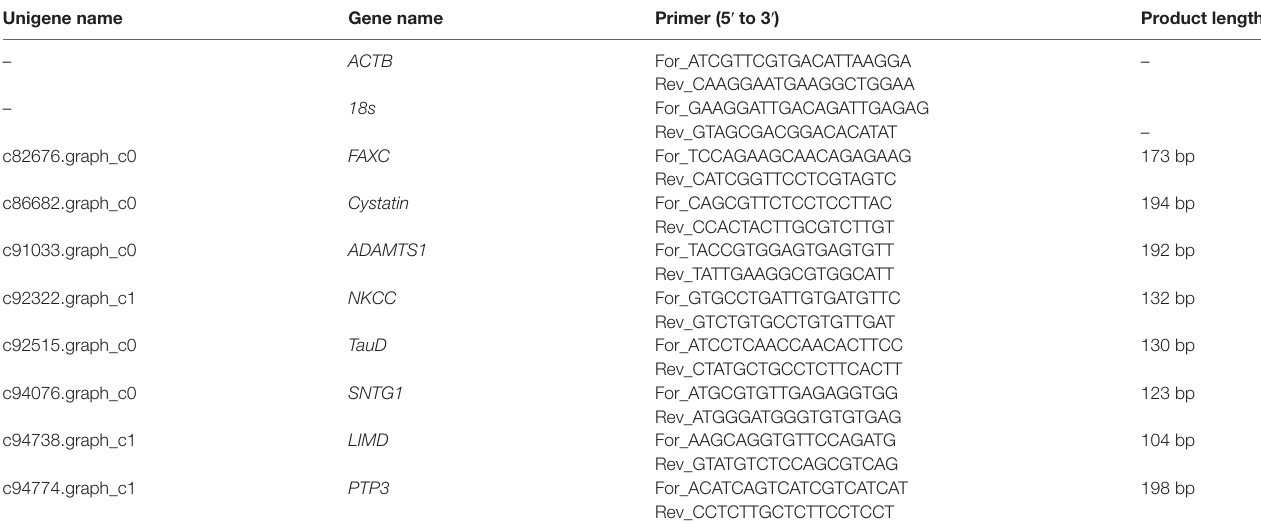
TABLE 1 | Primers of reference genes and eight salinity fluctuations response-related